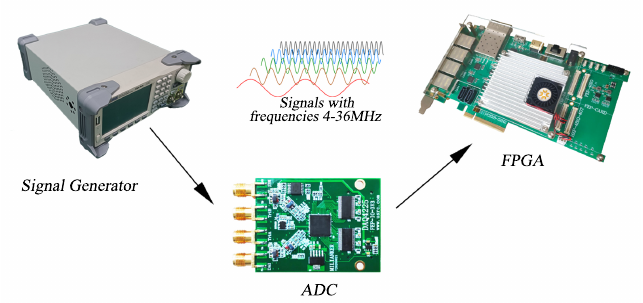
Figure 7. Diagram of a hardware − in − the − loop simulation system.